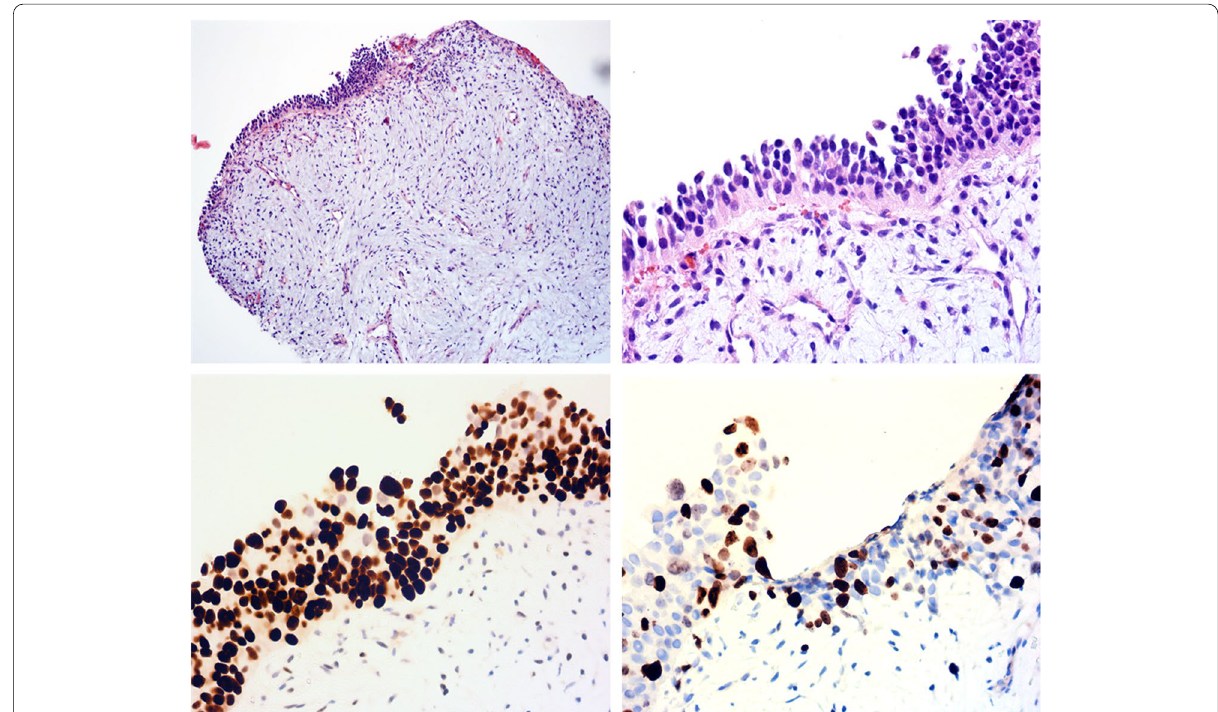
Fig. 2 Histological findings of the biopsy sample. a Low power view showed a stromal–epithelial lesion ( the surface showed mild-to-moderate dysplasia, cell polarity disorder, and inconspicuous mitosis. The myxoid stroma showed no dense cellularity, significant atypia, or mitosis ( 400). A diffuse expression pattern of p53 ( c ) and a relatively high proliferation index determined by Ki67 staining ( d ) × were found in the urothelium ( ×